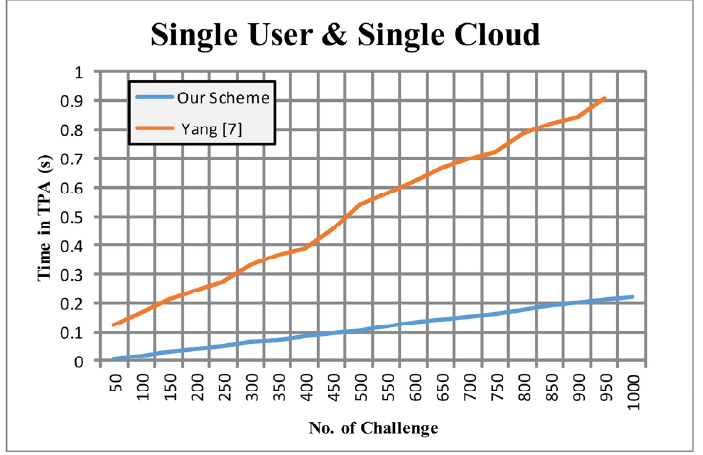
Figure 4. Computation cost on the semi ‐ trust server with the single smart device user and single IoT ‐ cloud system.